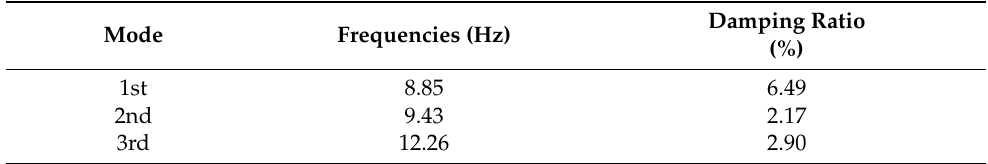
Table 2. Identified modal parameters from the first setup.